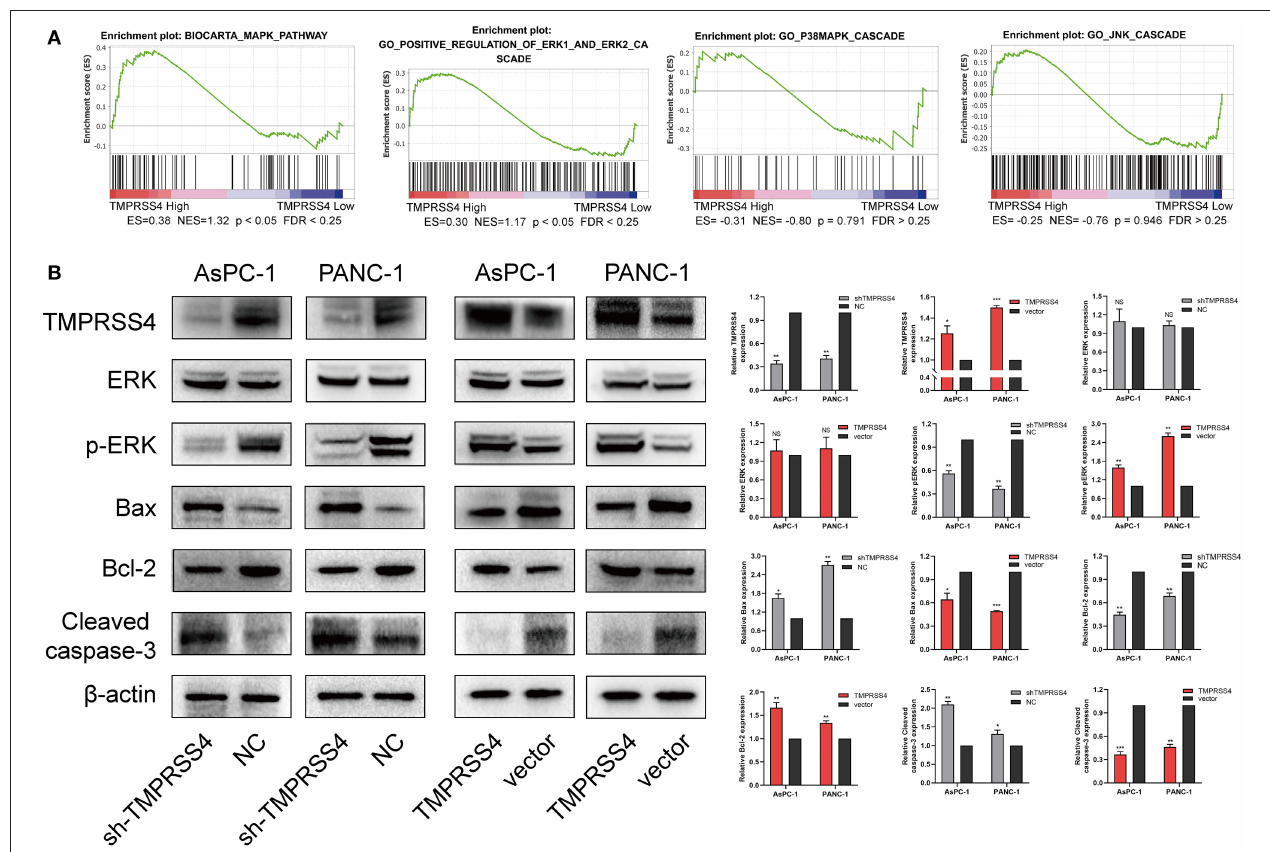
FIGURE 4 | TMPRSS4 activated the ERK1/2 signaling pathway in pancreatic cancer. (A) GSEA indicates a significant association between the mRNA expression levels of TMPRSS4 and the MAPKs pathways, in particular, the ERK1/2 signaling pathway in pancreatic cancer. The other two classical signal pathways of MAPKs, that is, JNK and p38, showed no positive correlation with TMPRSS4 . (B) Western blot analysis of TMPRSS4, total ERK1/2, phosphorylated ERK1/2, Bax, Bcl-2, and cleaved caspase 3; in the indicated cells. β -actin was used as a loading control. Each bar represents the mean ± SD of three independent experiments. Paired Student’s t-test was applied. * P < 0.05; ** P < 0.01; *** P < 0.001; GSEA, Gene Set Enrichment Analysis; MAPKs, Mitogen-activated Protein